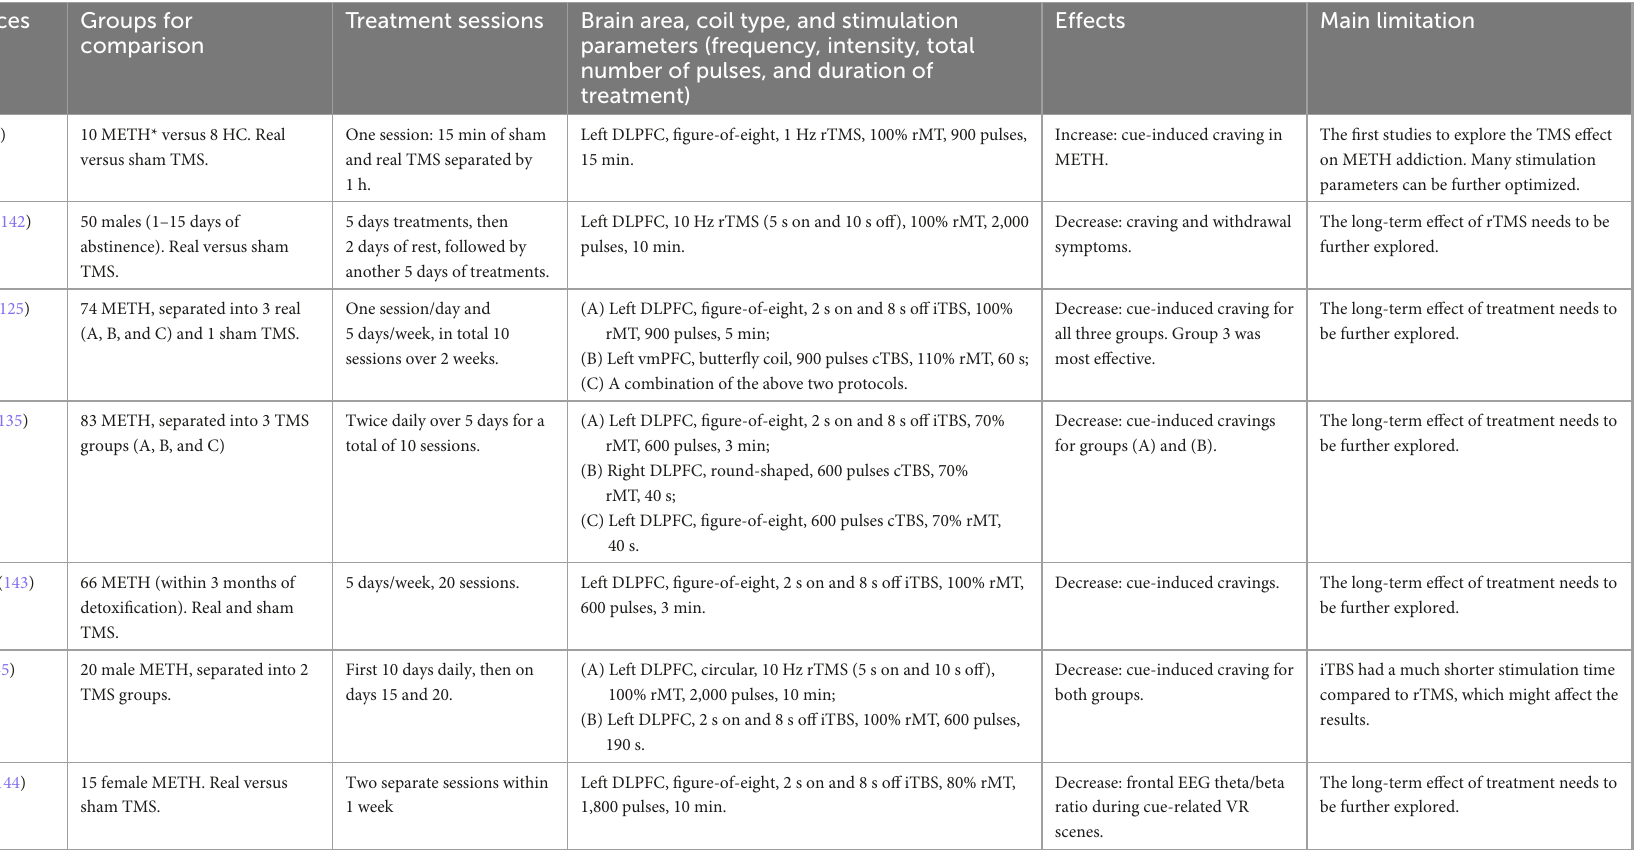
TABLE 5 Examples of TMS treatments for methamphetamine